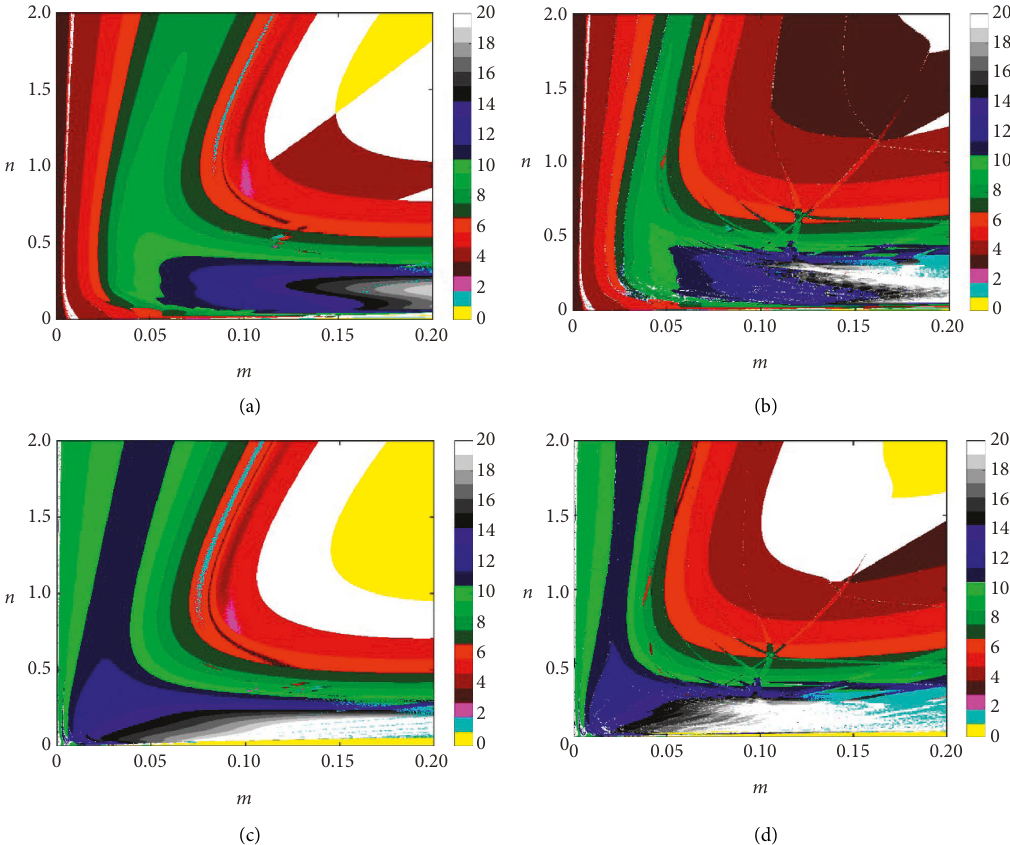
Figure 5: Discharge mode evolution diagram of system (10) under different controllers Γ (a) evolution diagram under Γ evolution diagram under Γ